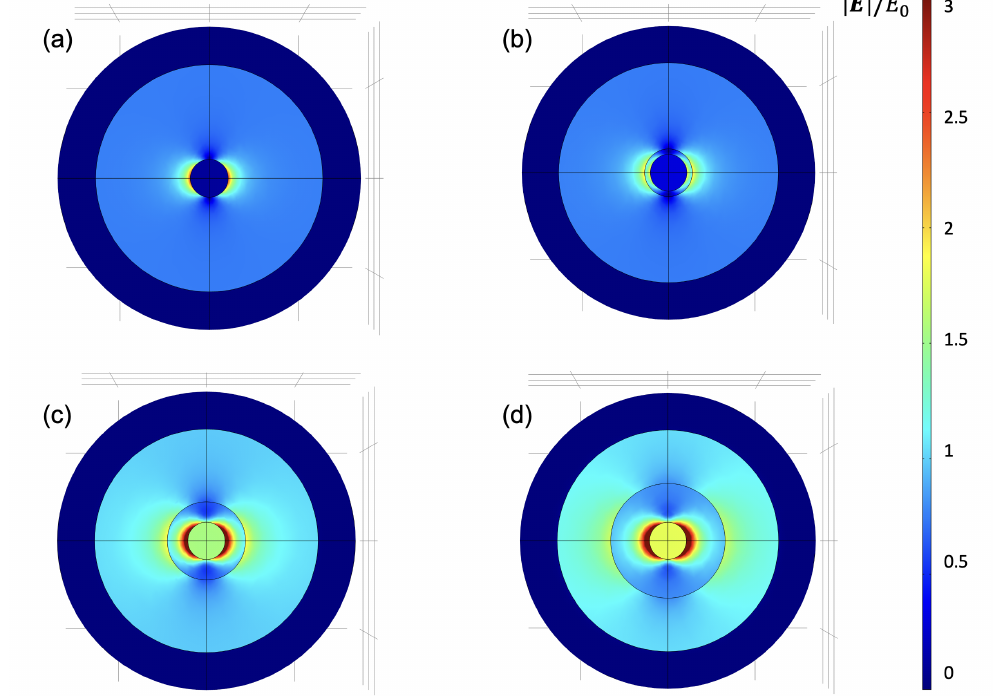
Figure 7. Finite element method (FEM) simulations reporting the local enhancement near-field around ( a ) GGPE 0 , ( b ) GGPE 3 , ( c ) GGPE 11 , and ( d ) GGPE 21